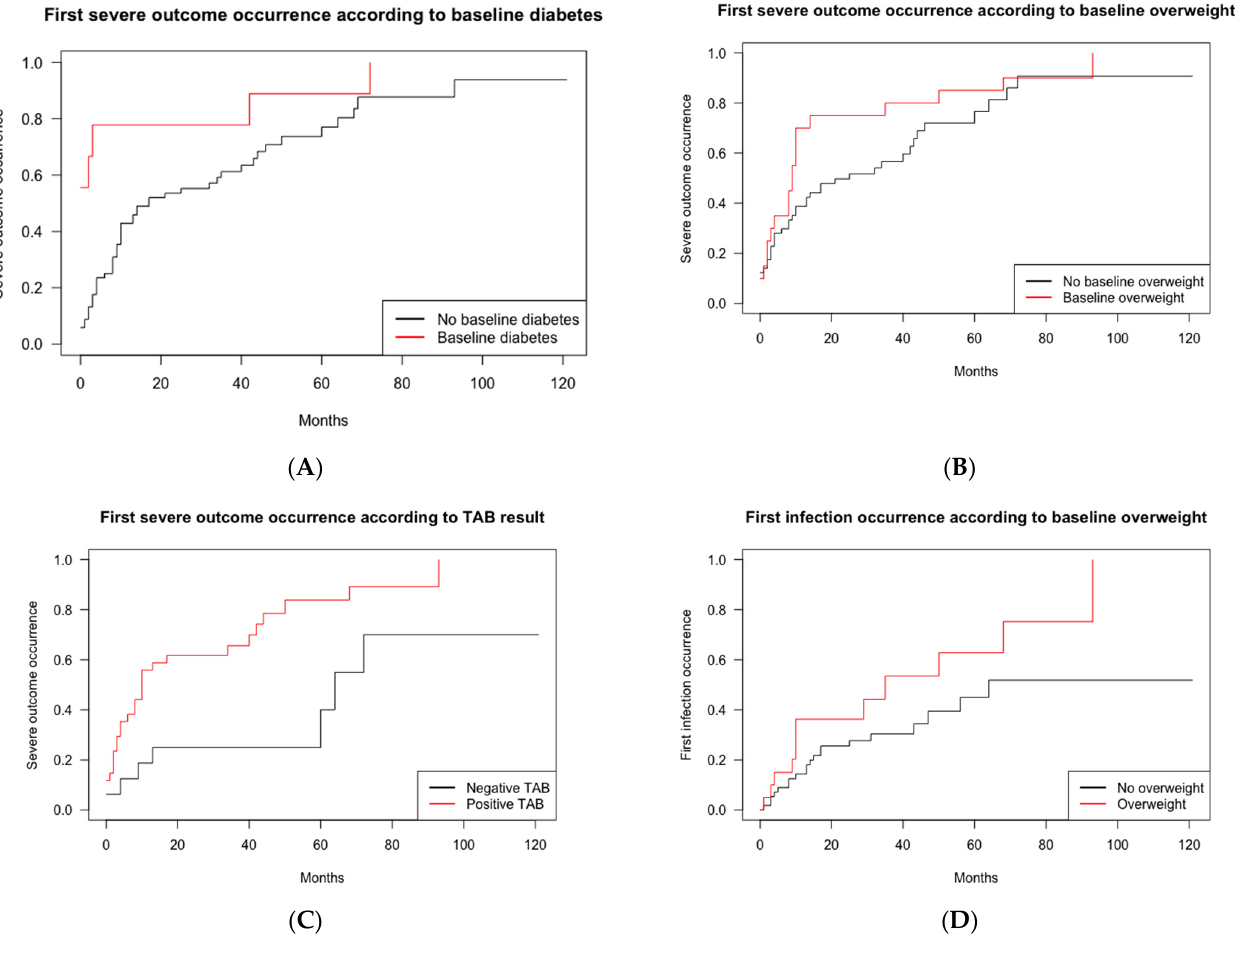
Figure 3. Risk of severe outcomes occurrence in the 77 patients with giant cell arteritis, according to the baseline characteristics (survival analysis). Survival curves illustrating severe outcomes onset according to the baseline characteristics in GCA patients. GCA, giant cell arteritis; TAB, temporal artery biopsy. The patients with baseline diabetes were at an increased risk of severe outcome onset (HR, 3.34 (1.52–7.35), p = 0.003) ( A ), as were the patients with baseline overweight (BMI ≥ 25 mg/m 2 ) the patients with a TAB ( n = 50), the patients with TAB positivity ( n = 34) were at an increased risk of severe outcomes compared to the GCA patients with a negative TAB (HR, 5.34 (1.81–15.76), p = 0.002) independently of age, sex, overweight, and dyslipidemia (the association with diabetes and smoking was maintained). ( D ) The risk for the first infection was increased in the overweight GCA patients